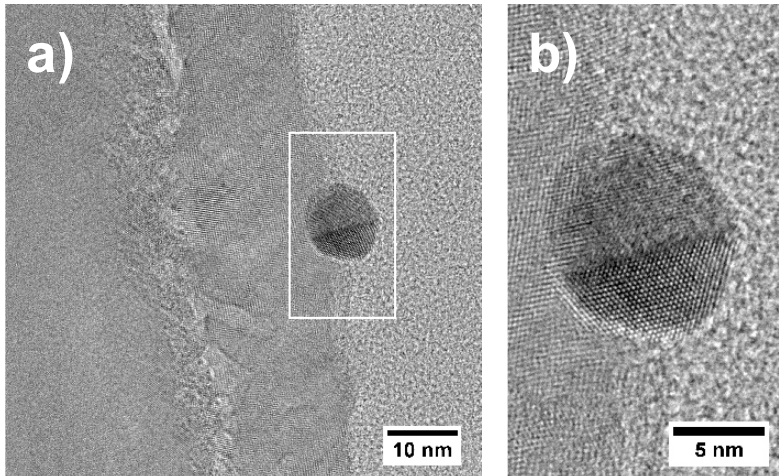
Figure 10. ( a ) HRTEM image of the oxide layer and an Au nanoparticle in sample “Au/Pt”. The frame indicates the region which was digitally magnified; ( b ) digitally magnified image of an Au nanoparticle indicating that these particles are polycrystalline.